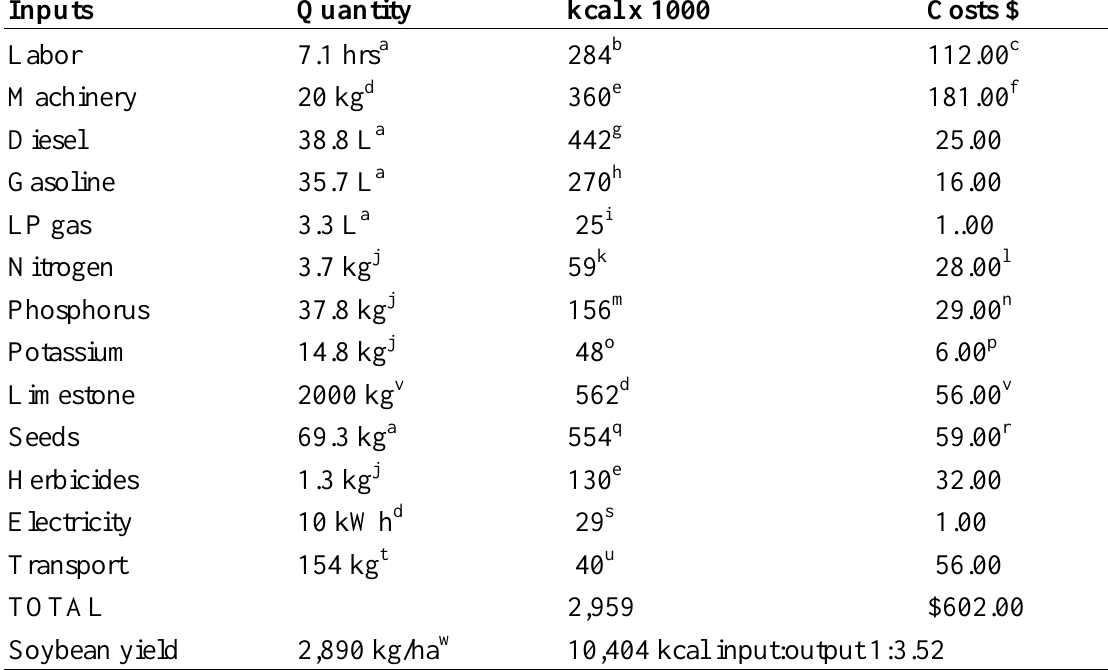
Table 8. Energy inputs and costs in soybean production per hectare in the